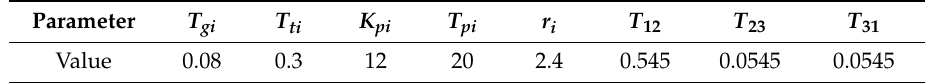
Table 1. Constrained parameters.